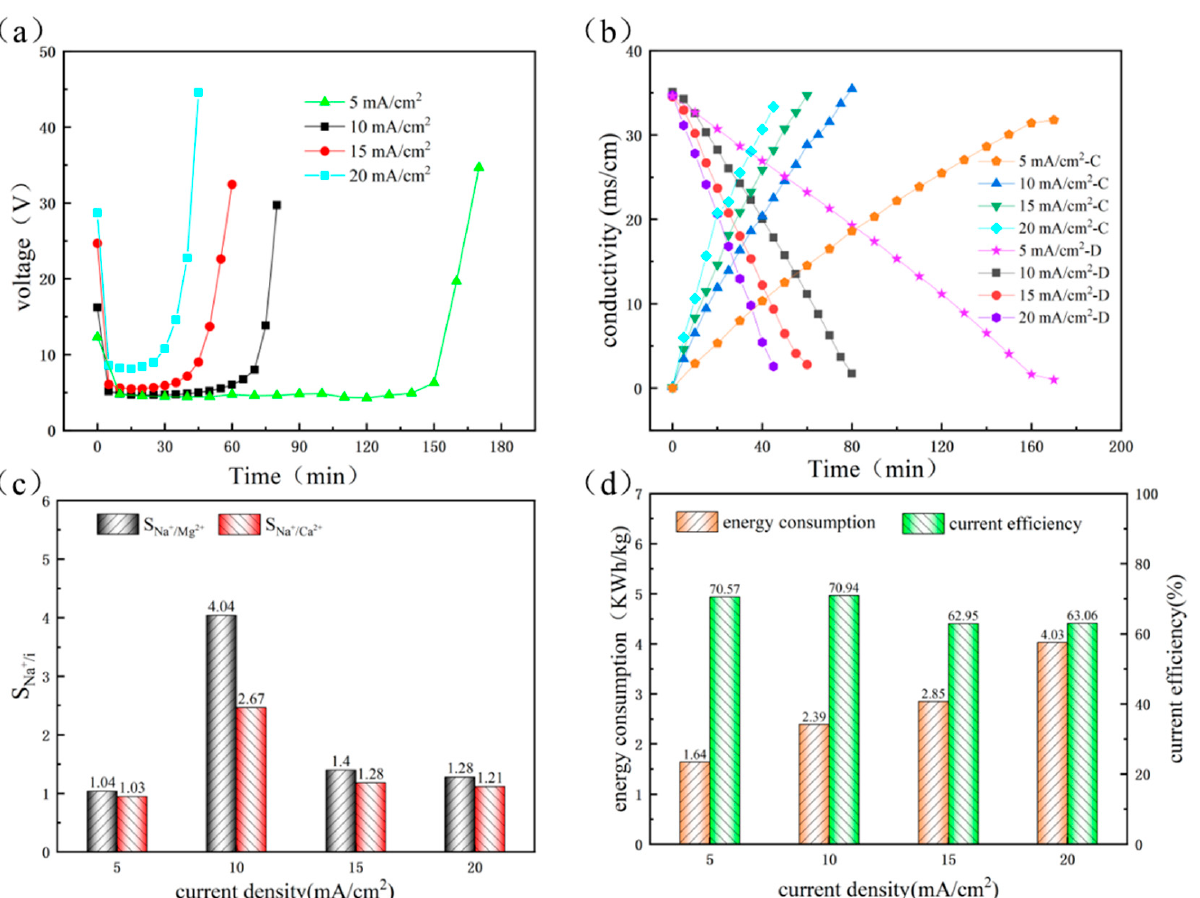
Figure 5. Effect of current density in SED process: ( a ) voltage drop, ( b ) desalination rate in dilute and concentrate compartment, ( c ) separation coefficient of Na + /Mg 2+ and Na + /Ca 2+ , and ( d ) energy consumption and current e ffi ciency.